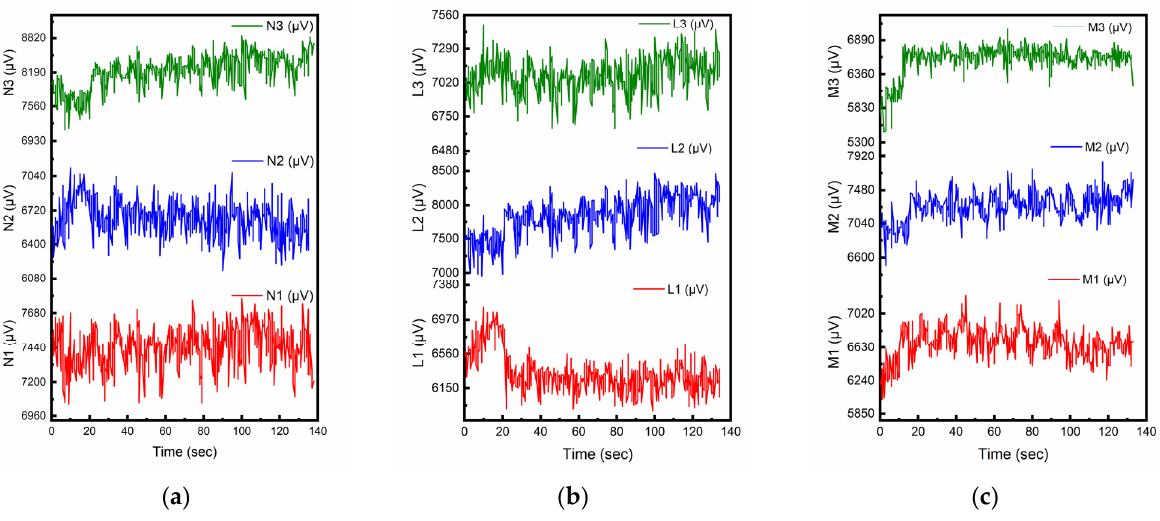
Figure 6. Piezoelectric responses for the NaDDBS surface treatment method with different concrete constituents. ( a ) W/C = 0.6 (Cement Only). ( b ) W/C = 0.6 (Cement:Sand= 1:2). ( c ) W/C = 0.6 (Cement:Sand:Aggregate = 1:2:3).